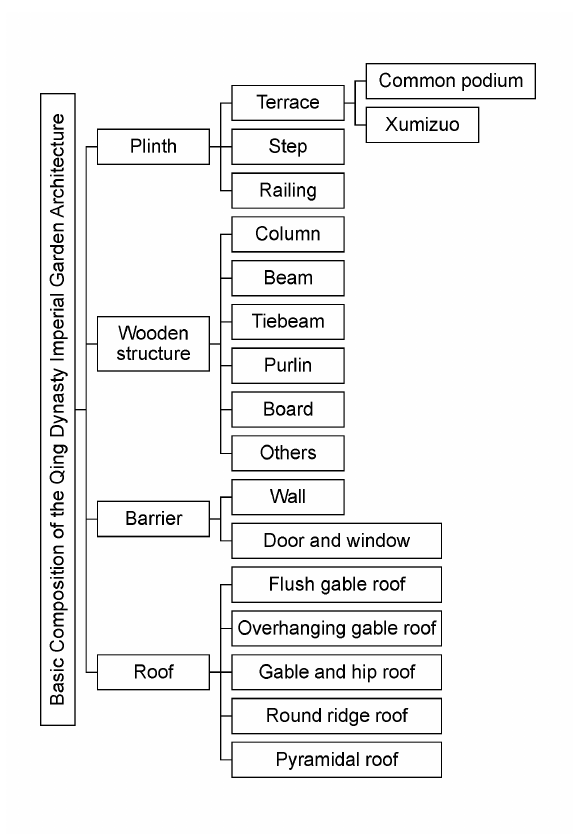
Figure 1. Basic Composition of Qing Dynasty Imperial Garden Architecture